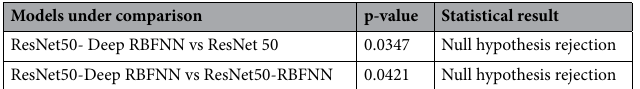
Table 8. Significance test with level of significance